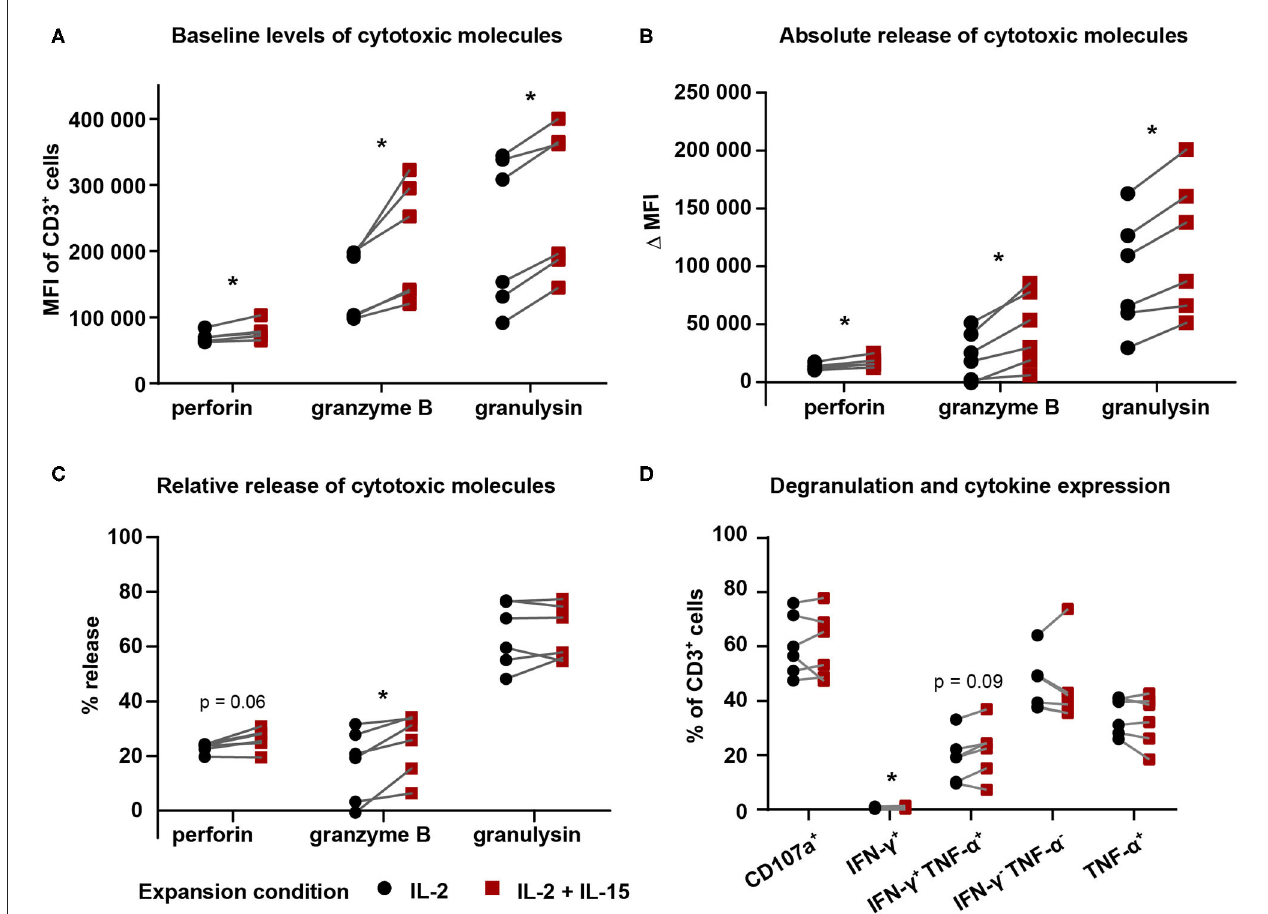
FIGURE 4 | IL-2/IL-15-expanded V γ 9V δ 2T cells displayed higher levels and release of cytotoxic molecules. V γ 9V δ 2T cells cryopreserved on day 25 were thawed and co-cultured in the presence of Brefeldin A and anti-CD107a antibody for 5h in the following conditions: (i) cell culture medium (baseline/negative), (ii) FM-28, or (iii) FM-28/ZOL. (A) Intracellular flow analysis was used to determine baseline levels of perforin, granzyme B, and granulysin in V γ 9V δ 2T cell cultures comparing both expansion conditions. (B) Absolute release of cytotoxic molecules (perforin, granzyme B, and granulysin) by V γ 9V δ 2T cells comparing IL-2-expanded and IL-2/IL-15-expanded cells. Absolute release was calculated based on the difference in MFI between FM-28-co-cultured and FM-28/ZOL-co-cultured V γ 9V δ 2T cells. (C) Relative release of cytotoxic molecules was calculated as the ratio of absolute release compared to the MFI of FM-28-co-cultured V γ 9V δ 2T cells. (D) Degranulation and cytokine expression of IL-2-expanded vs. IL-2/IL-15-expanded V γ 9V δ 2T cells was determined by gating on positive cells in FM-28/ZOL-co-cultured V γ 9V δ 2T cells. Gates were set according to the FM-28-co-cultured control. Since all cultures contained > 90% V γ 9 + cells of CD3 + cells, no γδ T cell marker was included in this panel. Instead, CD3 positivity was used to mark V γ 9V δ 2T cells. The Wilcoxon matched-pairs signed-rank test was applied to determine statistical significant differences between groups. Non-significant p values are not shown. * p < 0.05, MFI = mean fluorescence intensity ( n = 6 in one experiment; γδ